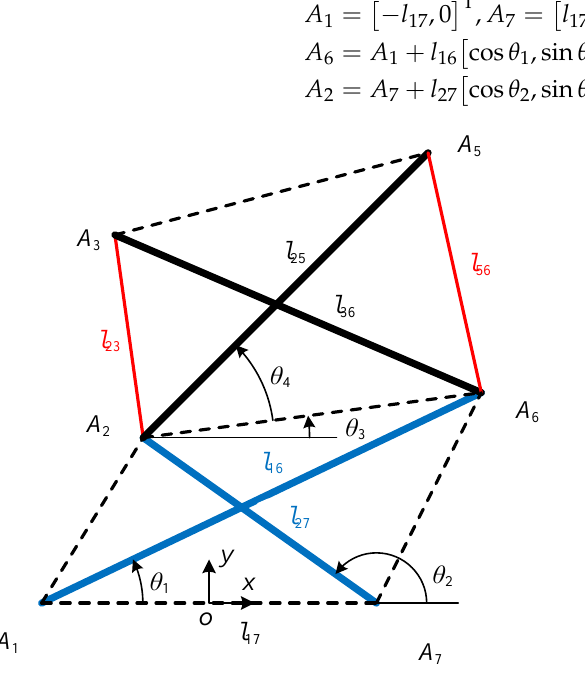
Figure 2. Actuation variables and generalized